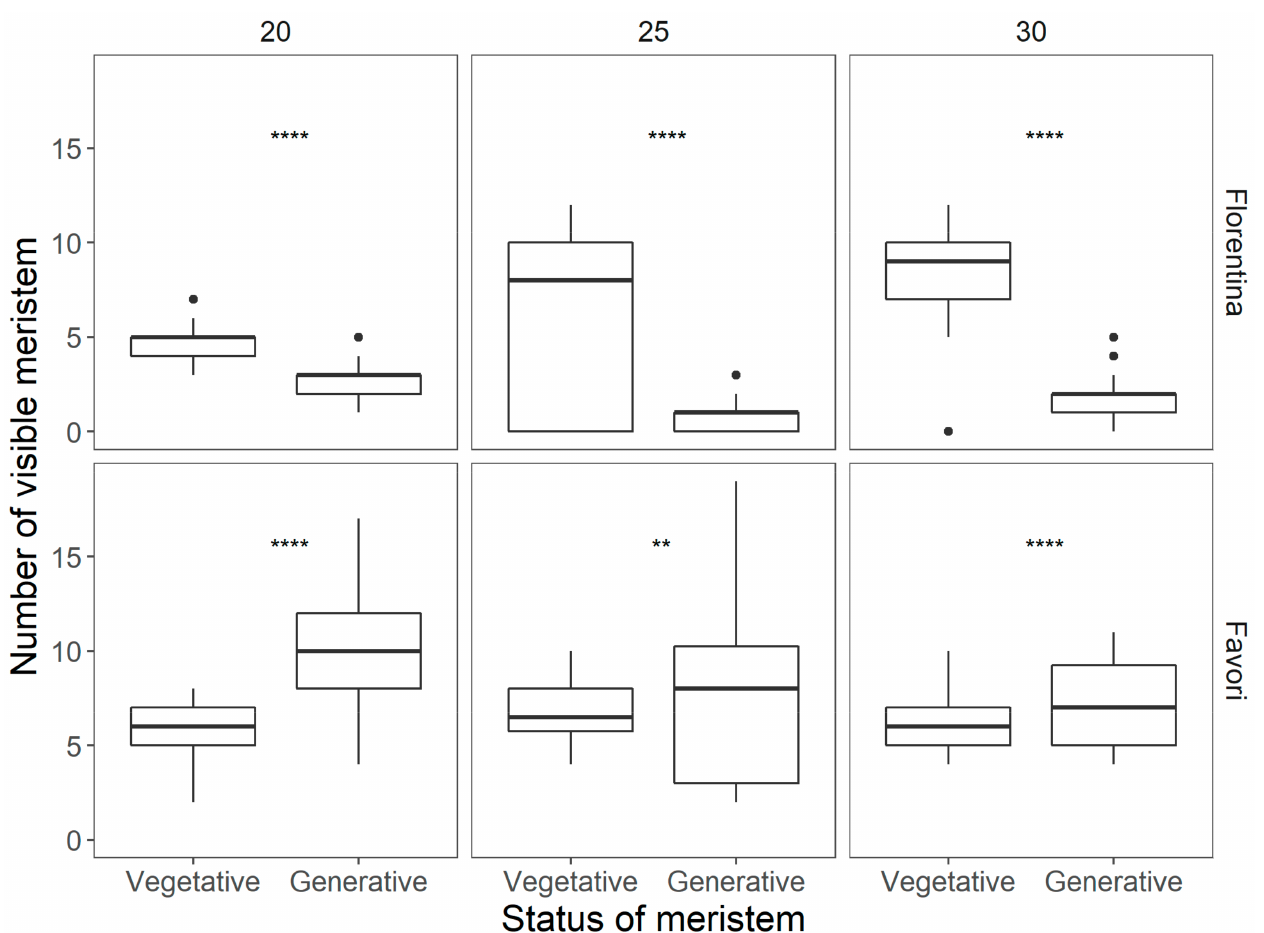
Figure 5. Differences in the status of the meristem at the end of 15 weeks of temperature treatments for each cultivar Statistically significant differences between the vegetative and generative stages were calculated by ANOVA and are indicated by asterisks (* p < 0.05; ** p < 0.01; *** p < 0.001; **** p <